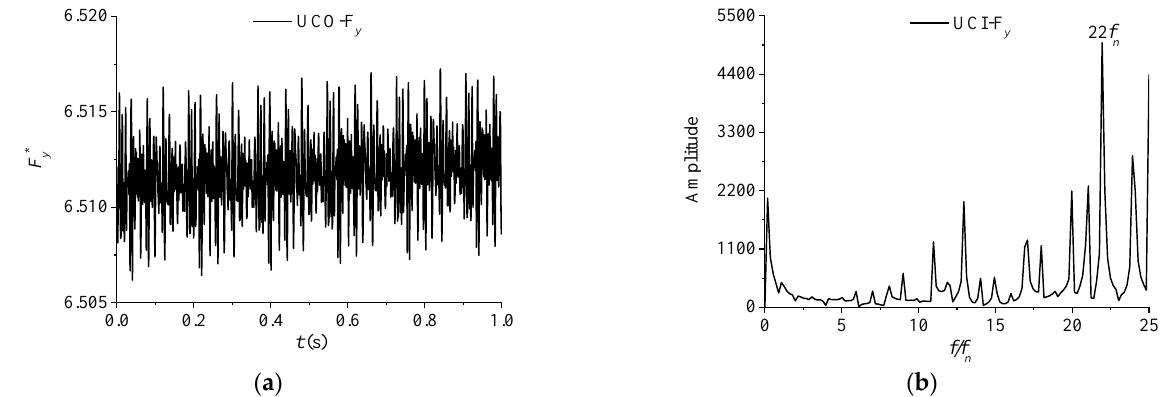
Figure 12. The axial water thrust of the runner upper crown inner surface. ( a ) Time domain diagram of UCI-F y . ( b ) Frequency domain diagram of UCI-F y .